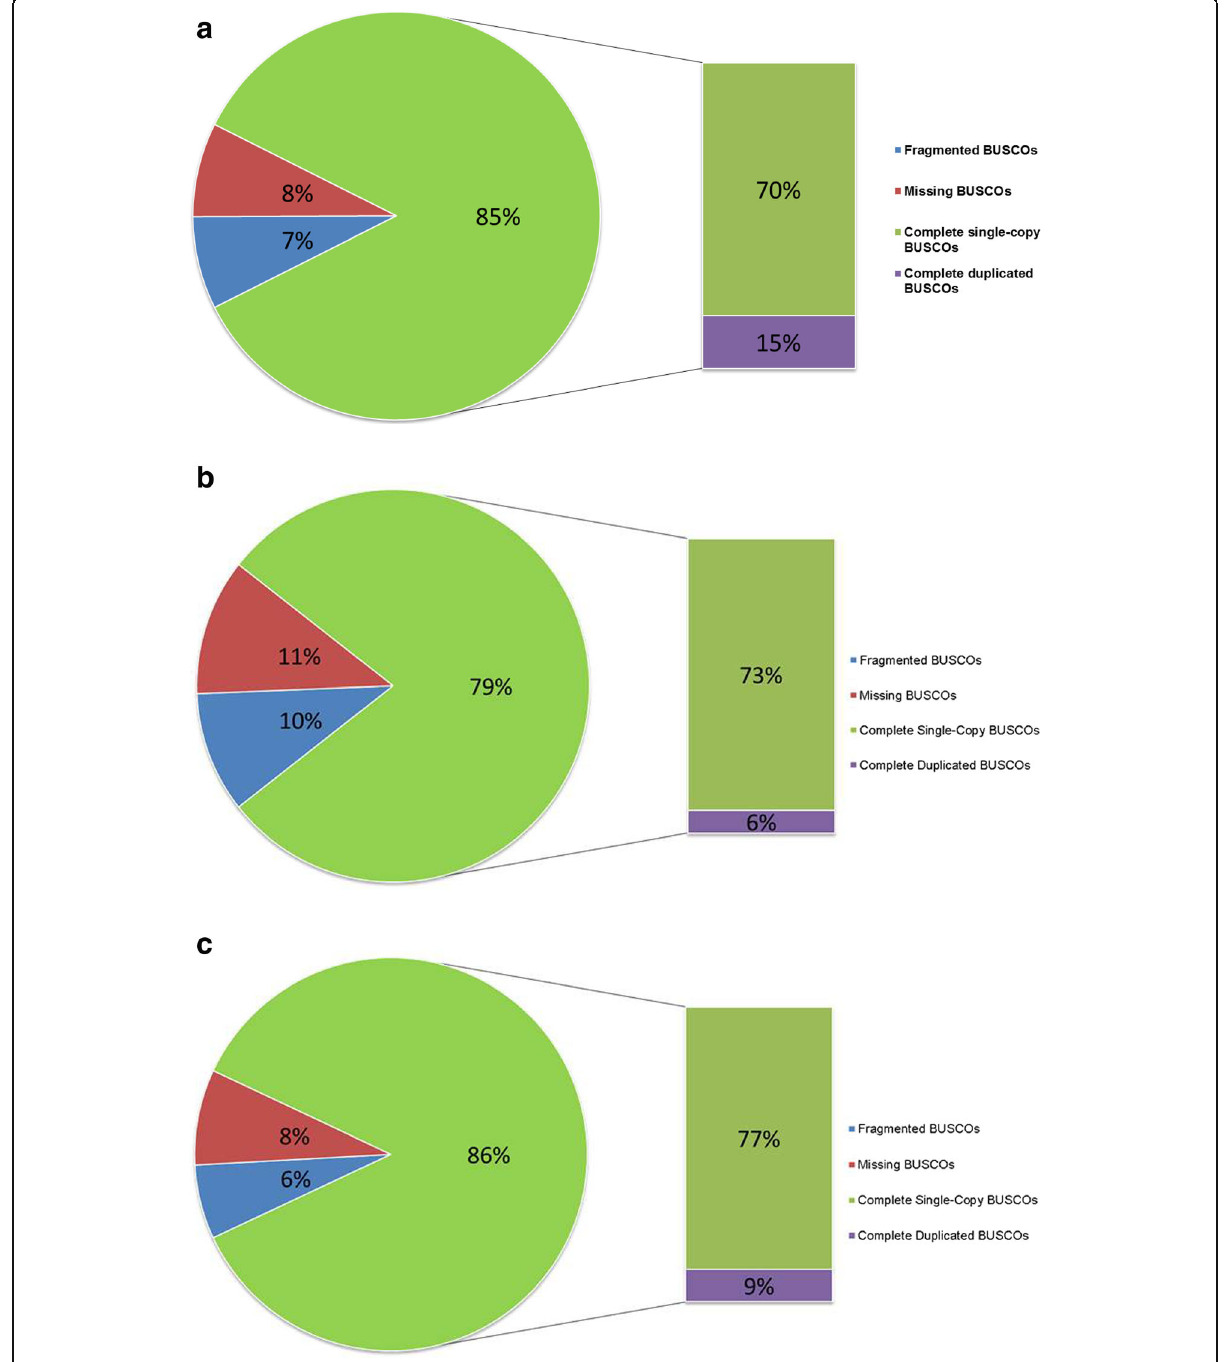
Fig. 3 Quantitative assessment of genome assembly through BUSCO. a BUSCO analysis utilizing D. noxia biotype SAM contigs; b BUSCO analysis utilizing D. noxia biotype RWA2 scaffolds (GCA_001186385.1) [15]; and c BUSCO analysis utilizing Acyrthosiphon.pisum scaffolds